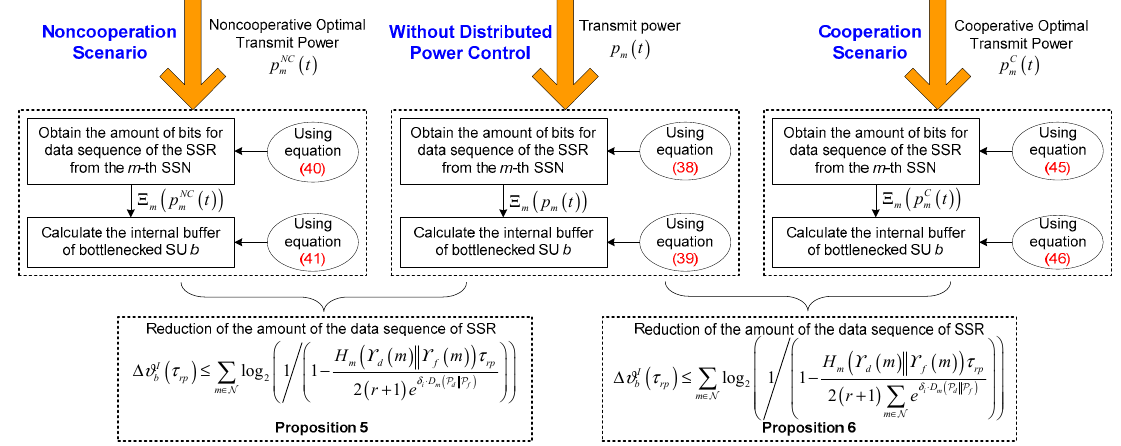
Figure 4. The block diagram of the key point to achieve congestion mitigation for bottleneck secondary user.